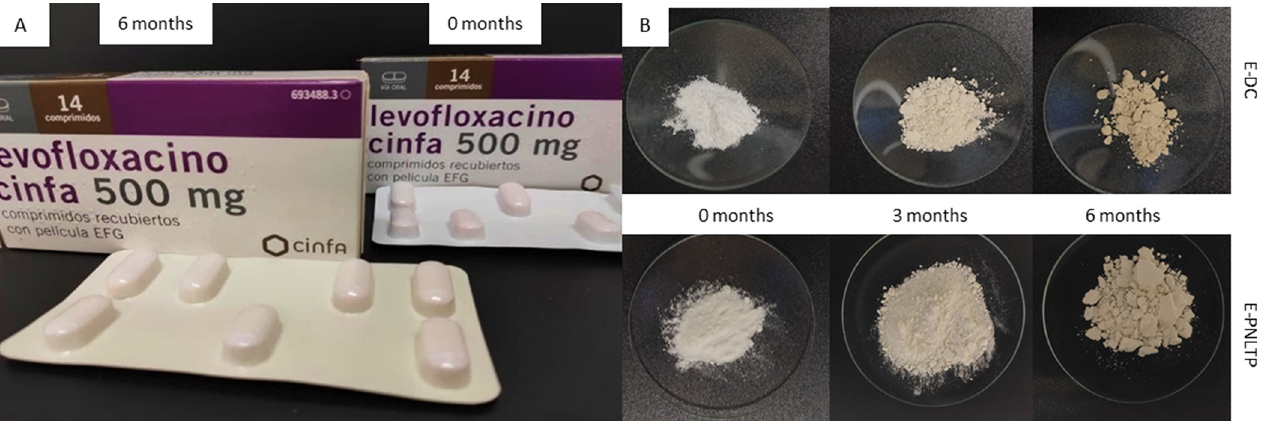
Fig 3. Appearance of packaging of LVFX-ML (A) and the solid powder ethambutol drug products (B) at different sampling times.